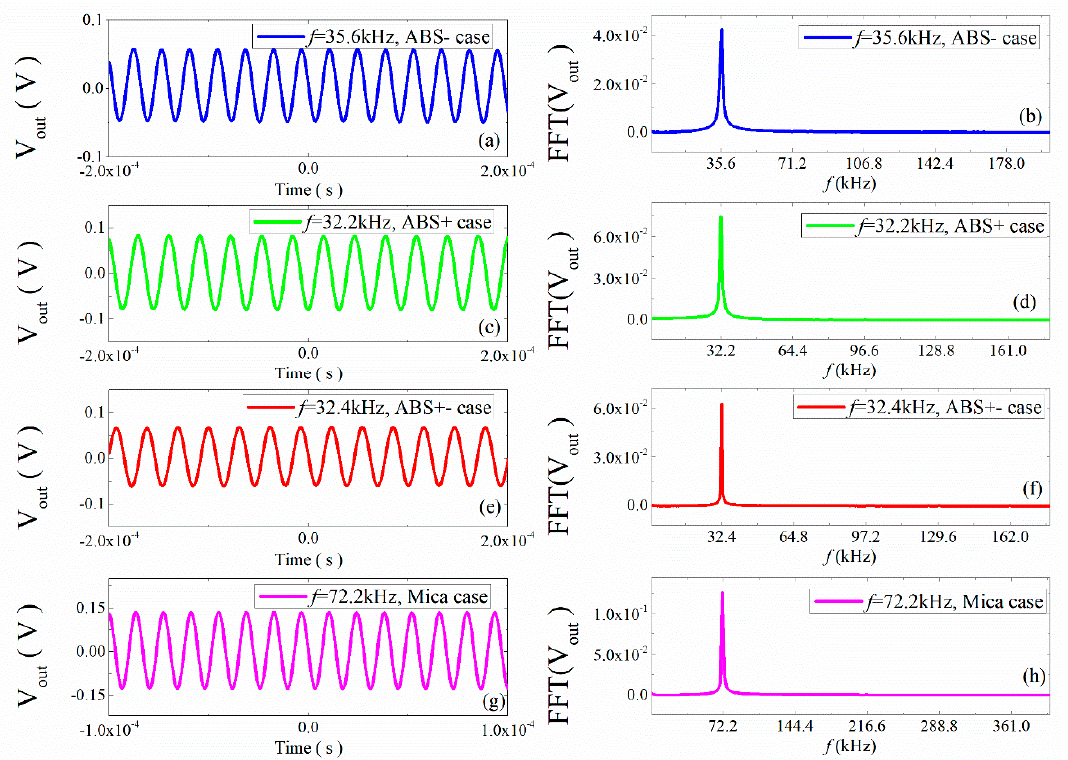
Figure 13. ( a , c , e , g ): Waveforms of ME voltage in the time domain for the ME structure at the higher resonance frequency; ( b , d , f , h ): the FFT spectral pattern for ME voltage.